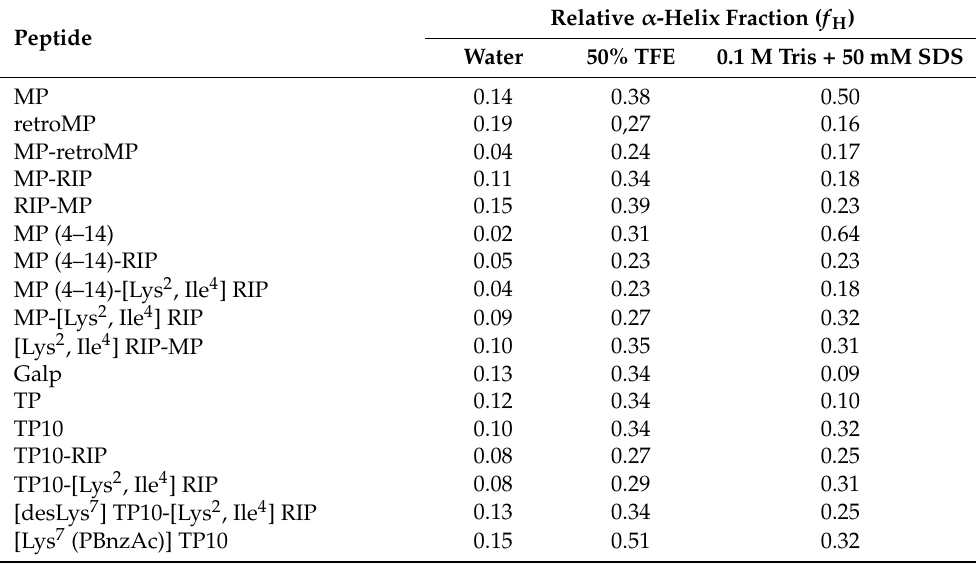
Table 4. The relative α -helix fraction ( f H ) calculated from the mean residue ellipticity values at 222 nm for the selected